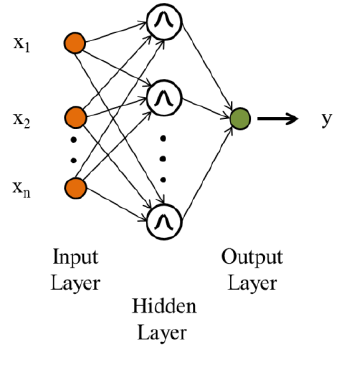
Figure 3. A RBFNN model with one output.